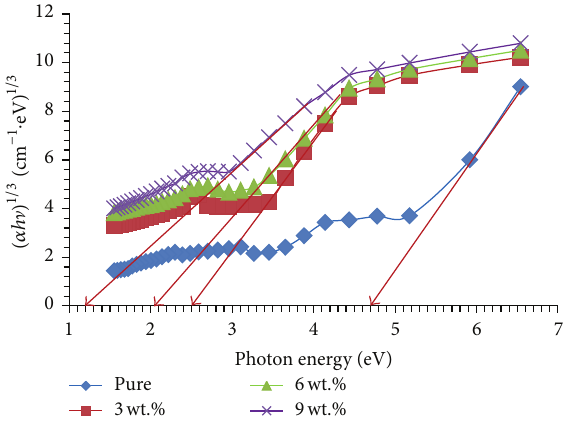
Figure 9: (𝛼ℎ𝜐) 1/3 versus photon energy of PVAc/0, PVAc/3, PVAc/6, and PVAc/9 wt.% of [Co(NH 3 ) 5 Cl]Cl 2 composites.